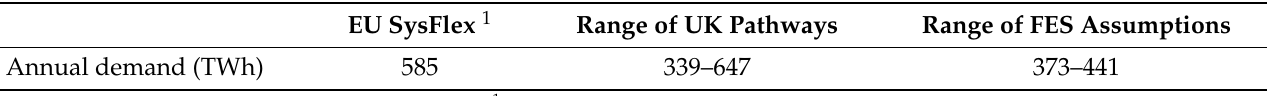
Table 1. Annual electricity demand for 2050